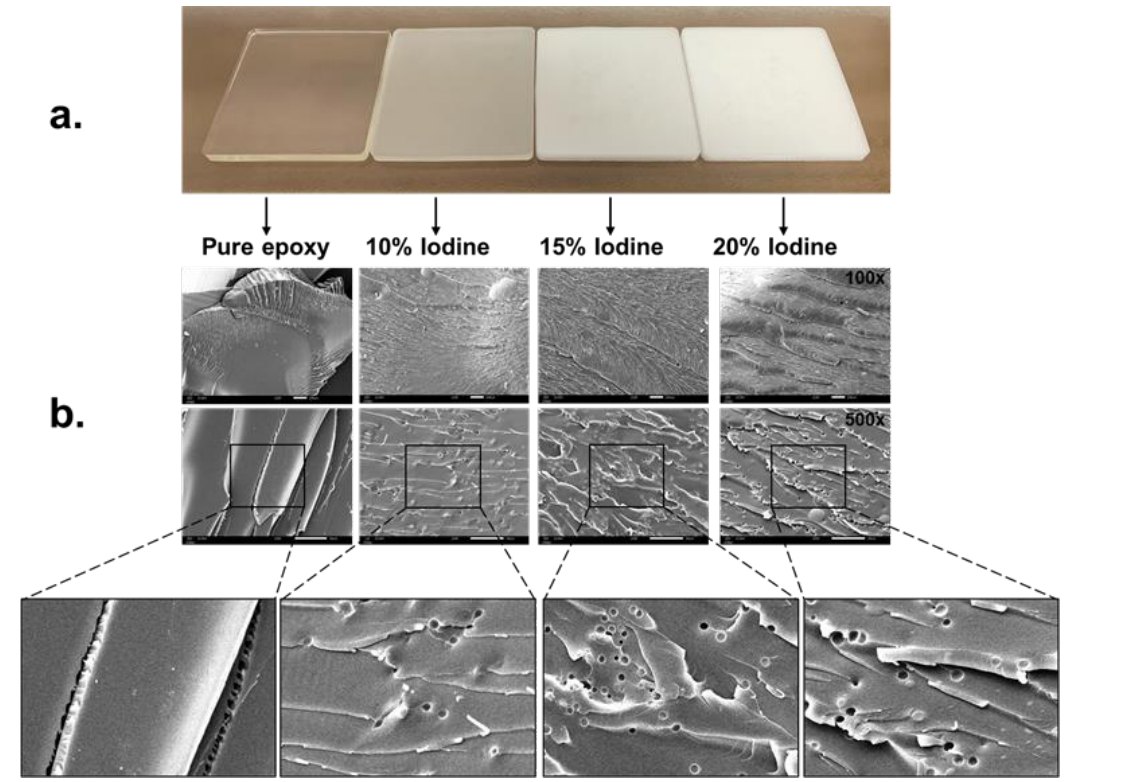
Figure 2. ( a ) The characteristic of epoxy resin shielding material. ( b ) The homogeneity of epoxy resin